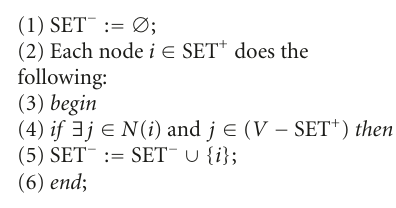
Algorithm 4: SET − finding procedure.